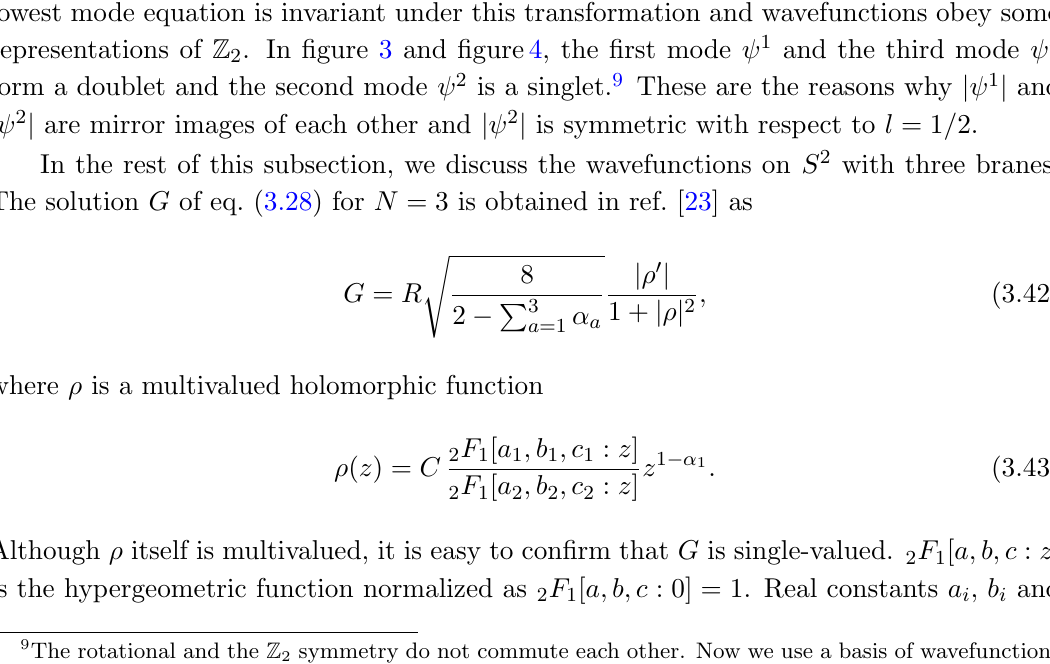
R vol( S 2 ) = 4 (cid:25)